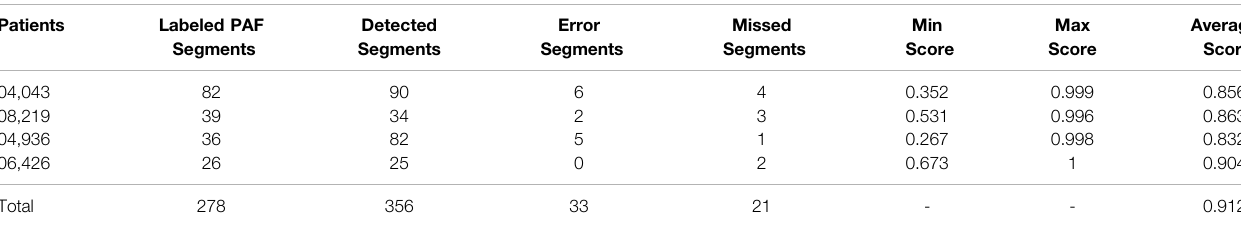
TABLE 2 | Result of the proposed method test on MIT-AFDB.